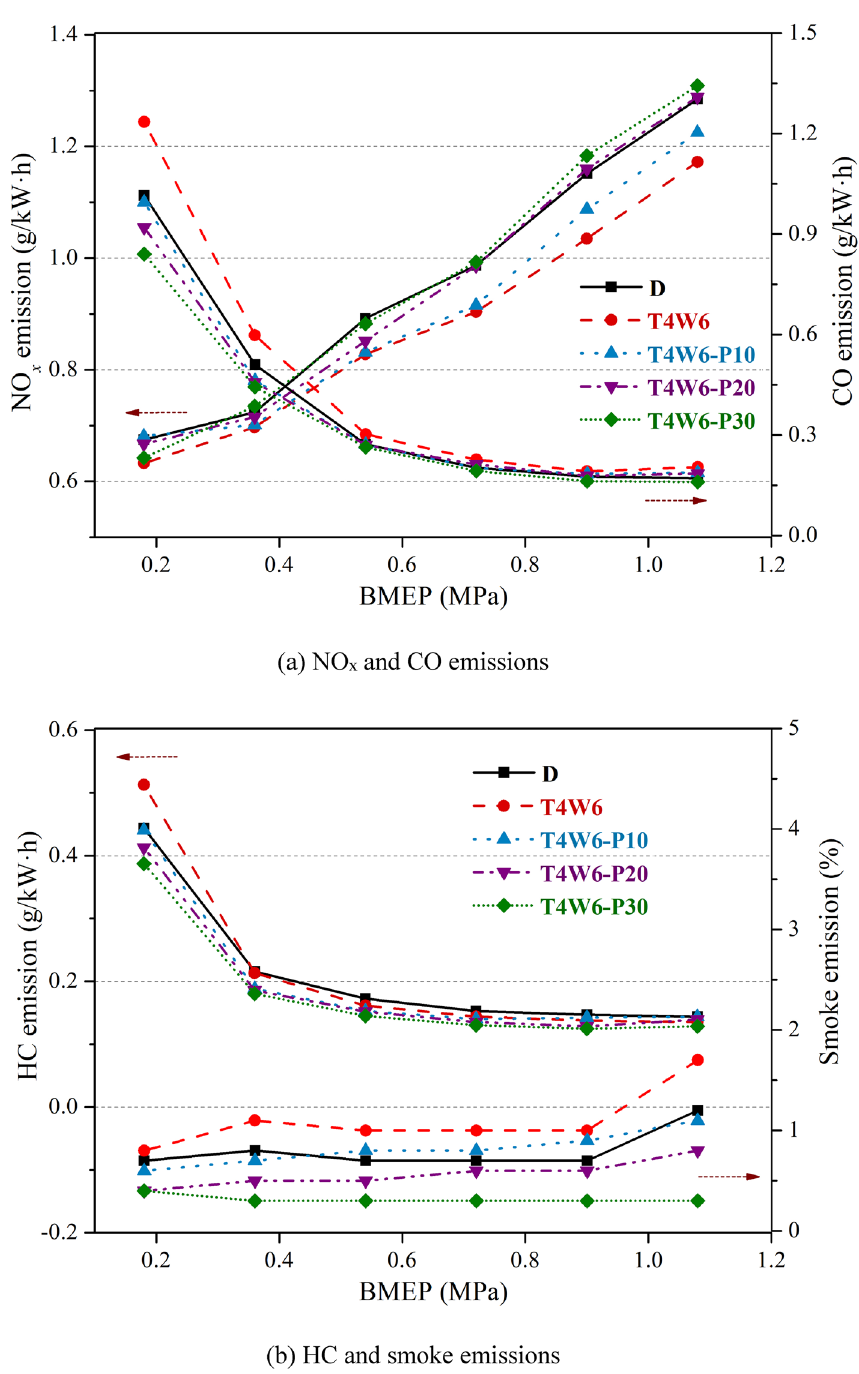
Figure 7. Effects of the PODEn blending ratio on the emission characteristics of the diesel